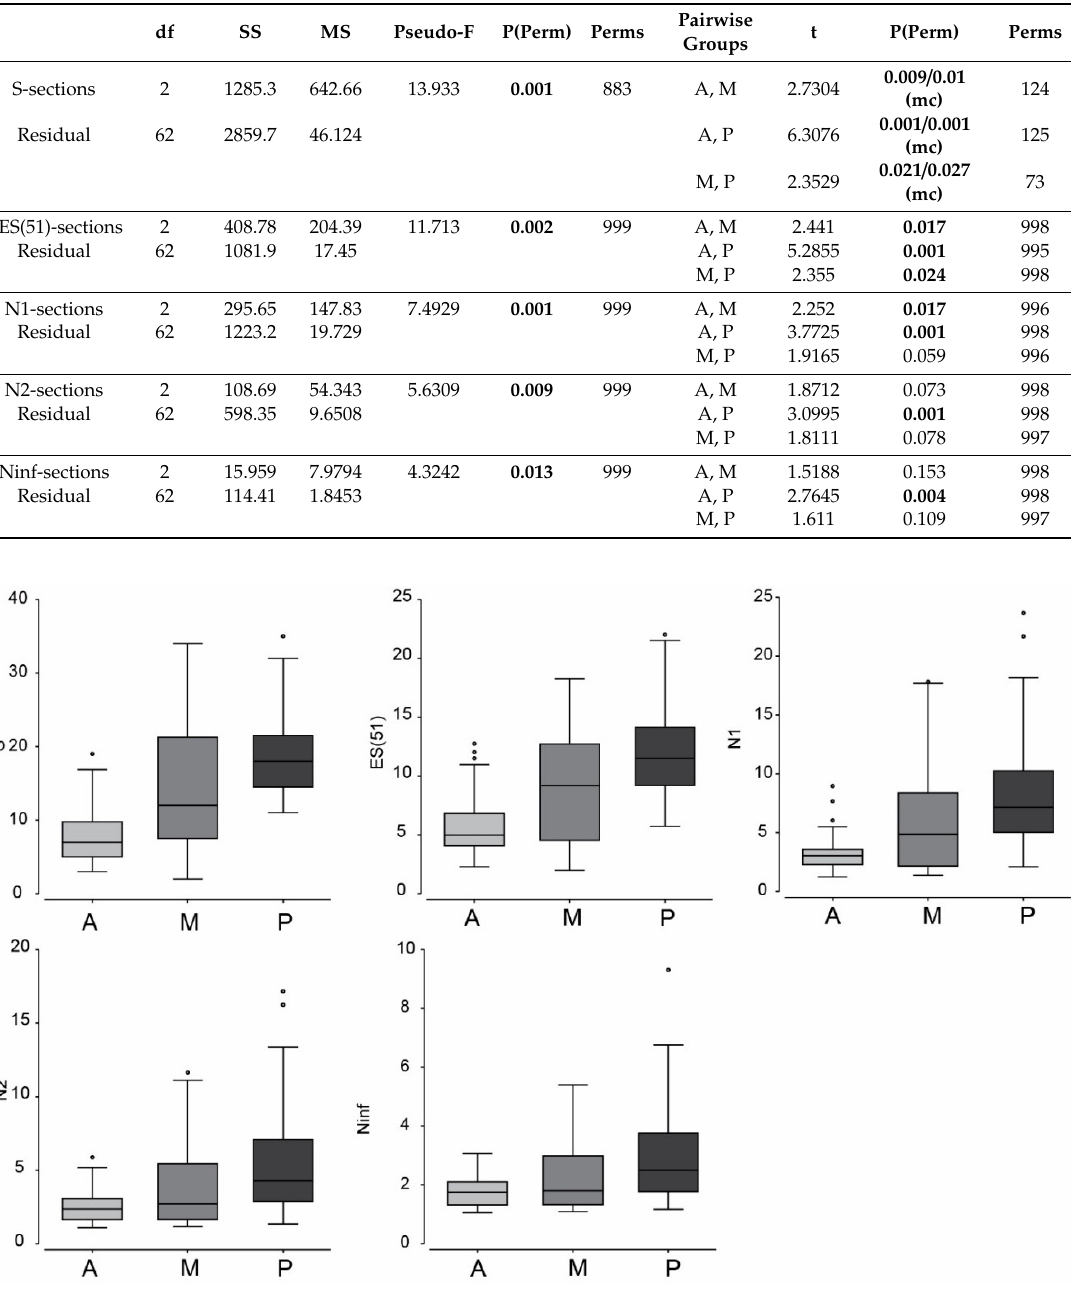
Figure 8. Box and Whisker (median, quartiles and ranges) plots of nematode genera diversity indices for each carapace section. S: nematode genus richness, ES(51): expected number of genera based on 51 individuals, N1: Hill’s index 1, N2: Hill’s index 2, Ninf: Hill’s index inf [40]. A = anterior, M = middle, P = posterior sections.